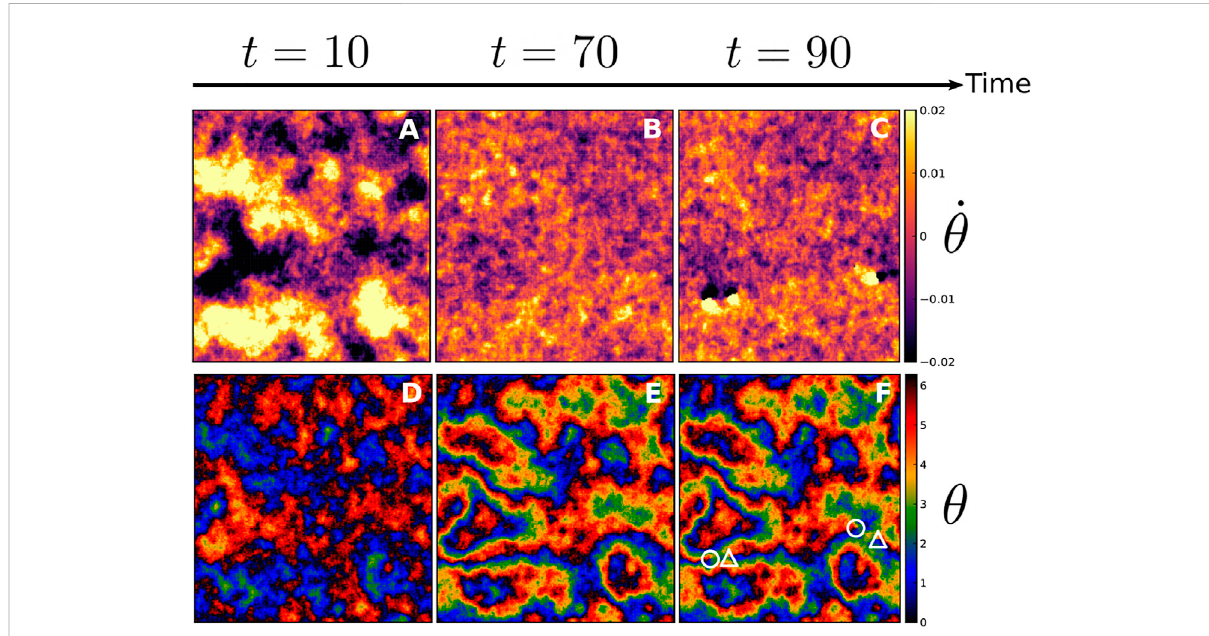
FIGURE 10 Threesnapshotsovertimeofthe fi elds _ θ ( x , y ) (A – C) and θ ( x , y ) (D – F) forasysteminitiallyorderedwith T =0.05and σ 2 =0.2.Inpanel (C) ,defects are clearly identi fi ed thanks to the localized and intense amplitude of the instantaneous frequencies. In panel (F) , +1 defects are highlighted by a circle, − 1 defects are highlighted by a